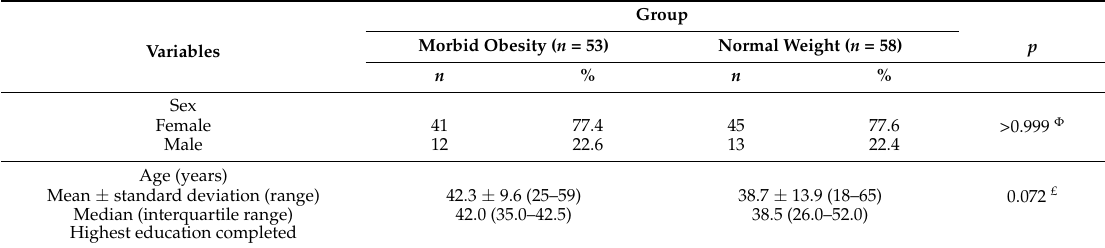
Table 1. Demographic details and body mass index of the participants with morbid obesity versus participants of normal